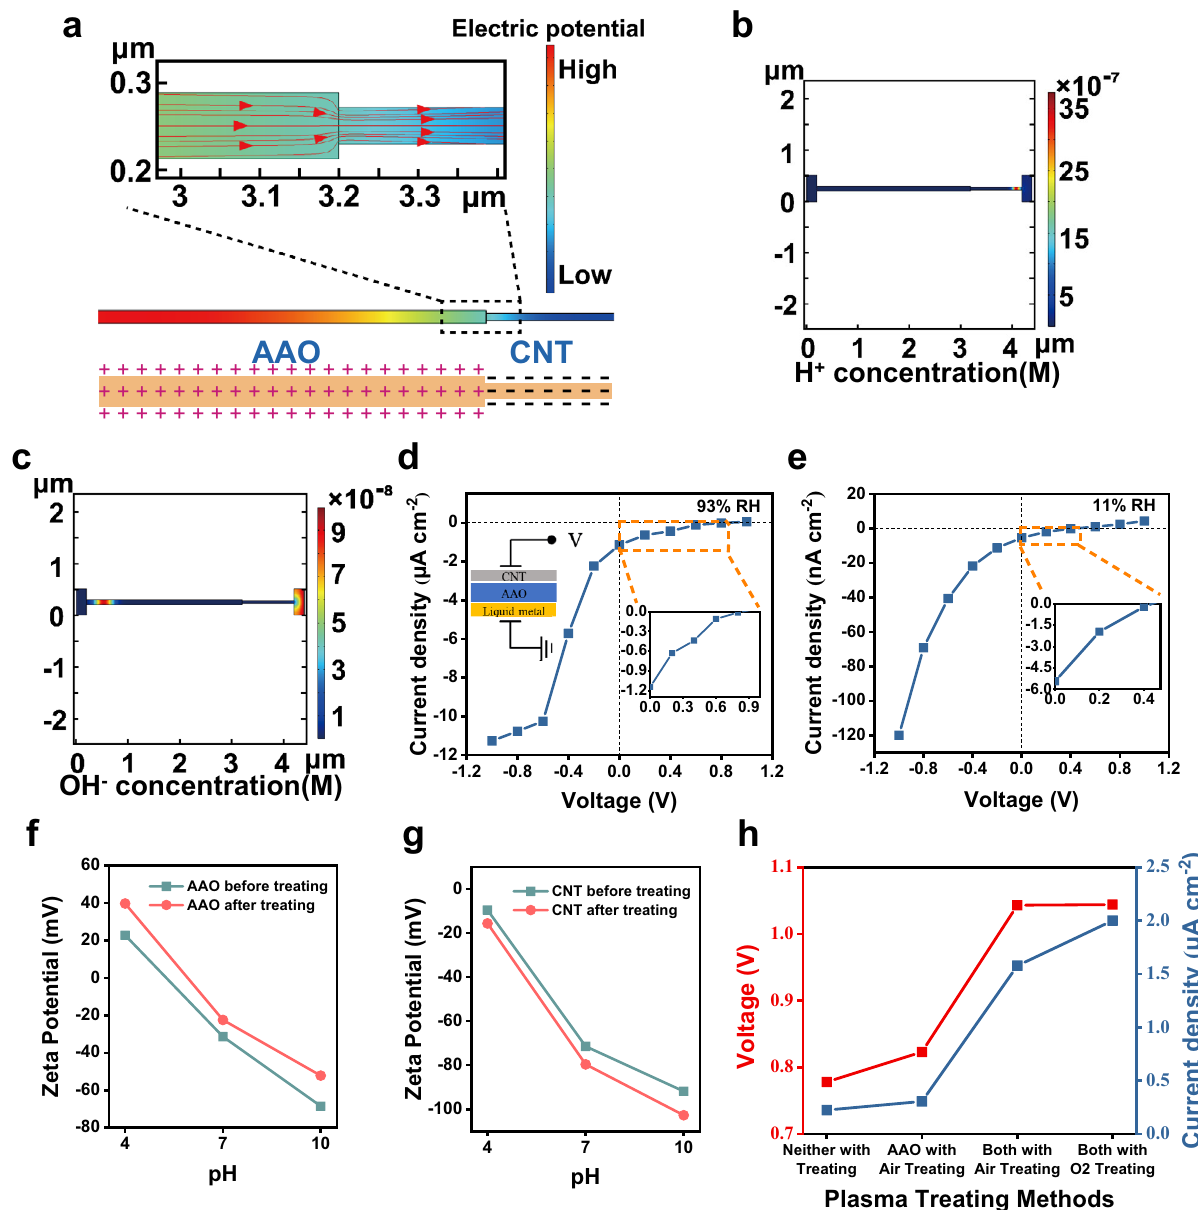
Fig. 3 Mechanism analysis of the HEEG. a The built-in electric fi eld distribution under no-bias condition: the inset is a magni fi ed view of the built-in electric fi eld direction near the junction. b Concentration distribution of H + under no-bias condition: H + is transferred to the CNT side under the action of the built- in electric fi eld. c OH − concentration distribution under no bias condition: OH − is transferred to the vicinity of the bottom electrode under the action of the built-in electric fi eld. d , e I-V sweeping curves for device in high and low RH condition, which effectively demonstrate the ion-diode characteristics for unidirectional electrical conduction. f , g Surface Zeta potential of CNT fi lm and AAO membrane in different pH condition before and after O-plasma treating, respectively, verifying effective surface modi fi cation. h Result of device ’ s V OC , I SC for four different plasma treating methods, and the HEEG shows the best performance after both membrane material being treated with oxygen